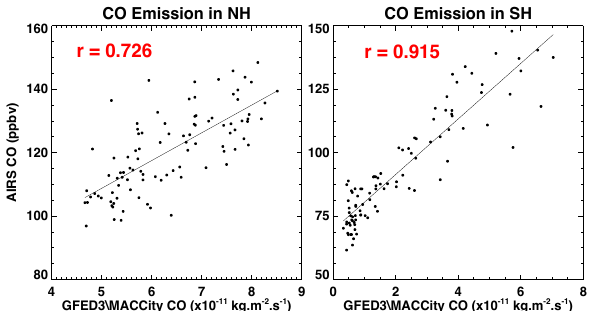
CO Emission in NH